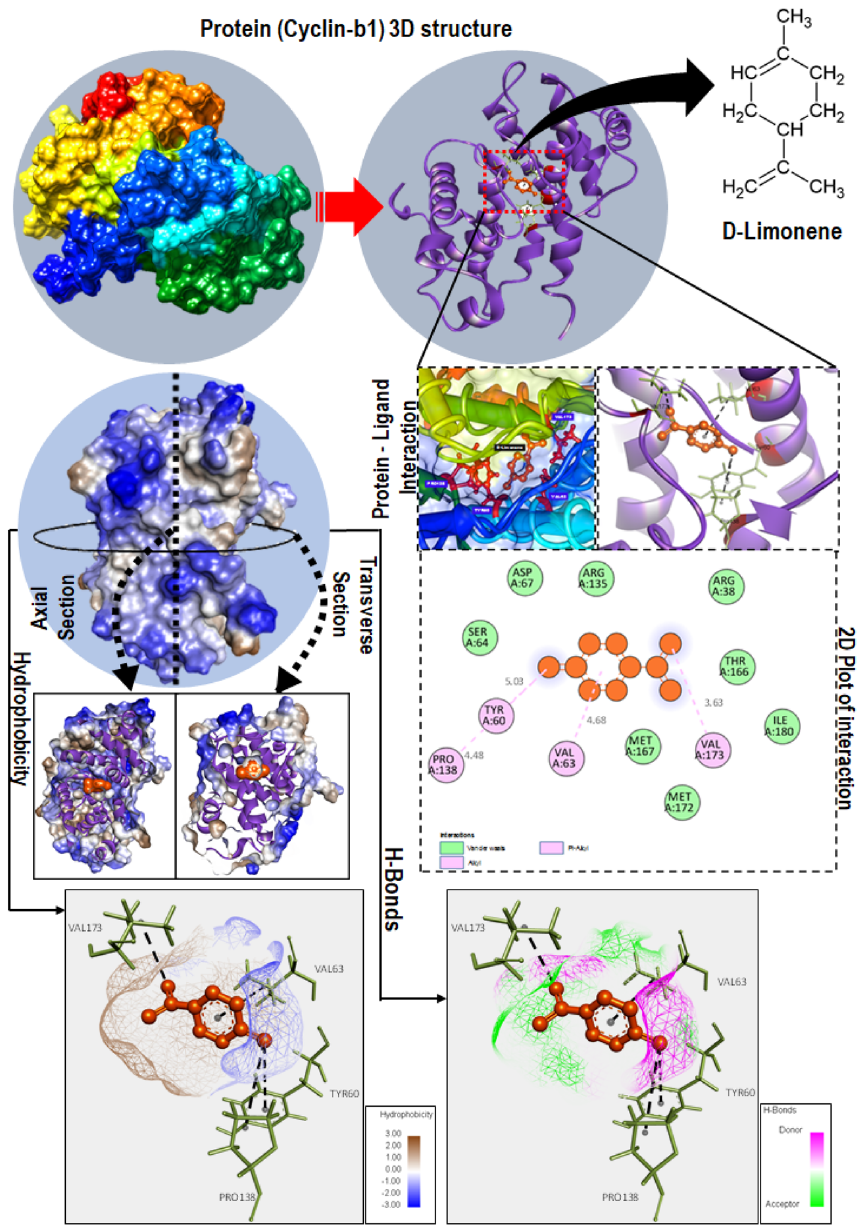
Figure 7. Molecular interaction of Cyclin B1 protein (Homo sapiens) residues with d-limonene as predicted through molecular docking. The docking was performed using Autodock Vina. d-limonene was predicted to interact with Cyclin B1 through tyrosine (TYR60), valine (VAL63, VAL173) and proline (PRO138) via hydrogen bond while there was also presence of Vander wall interaction through methionine (MET172, MET167), threonine (THR166), aspartic acid (ASP67) and arginine